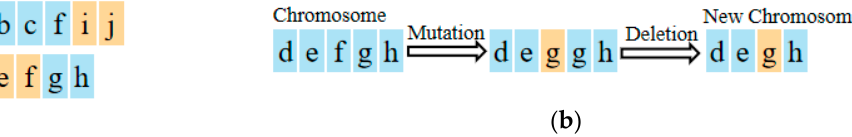
Figure 3. Schematic diagram of crossover and mutation operation. ( a ) Crossover; ( b ) Mutation.